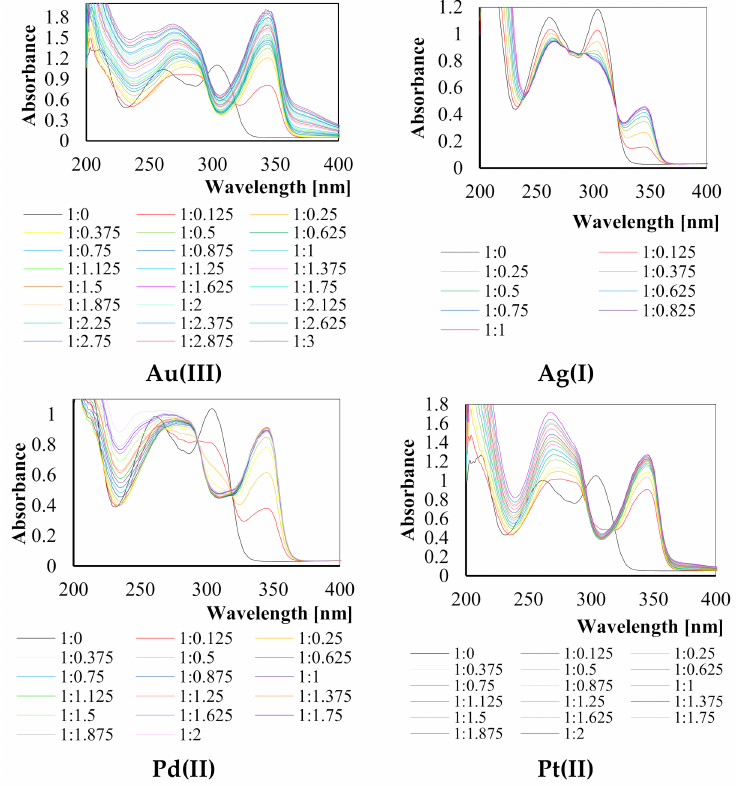
Figure 2. Absorption spectra of investigated systems of ligand to metal ions in various ratios (L:M). The obtained absorption spectra are characterized by absorption bands together with the isosbestic points in the UV region wavelengths ranging from 200 to 400 nm. Constant changes in the shapes of recorded spectra are related to the creation of new complexes with various ratios of ligand to the metal ion. Based on the above spectra, the stability constants of complexes of 2,6-bis(4-methoxybenzoyl)-diaminopyridine with Au(III), Ag(I), Pd(II) and Pt(II) ions were calculated and are presented in Table 1.